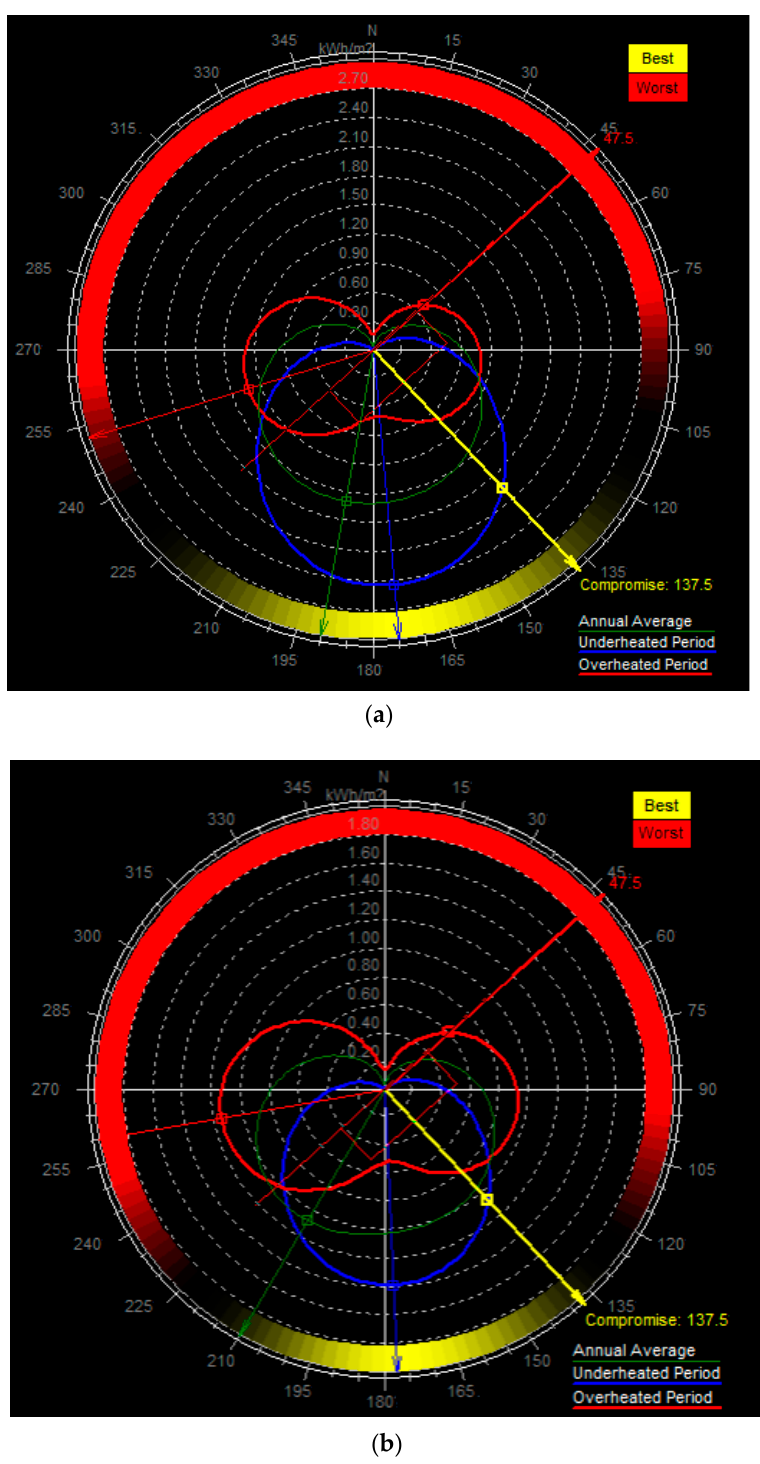
Figure 6. The best orientation of typical buildings in cold regions. ( a ) Beijing (42.5 degrees east south). ( b ) Shijiazhuang (42.5 degrees east south).